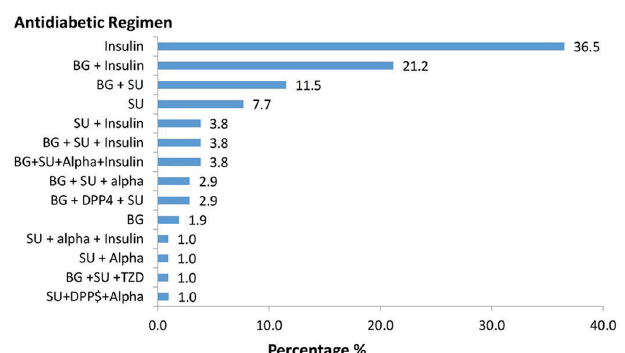
FIGURE 2 - Antidiabetic agents used in T2DM patient with DR (N=104); Alpha, alpha glucosidase; BG – biguanide; DPP4, Dipeptidyl peptidase-4 enzyme inhibitors; SU, sulphonylurea. peptidase-4 enzyme inhibitors; TZD, Thiazolidinediones.